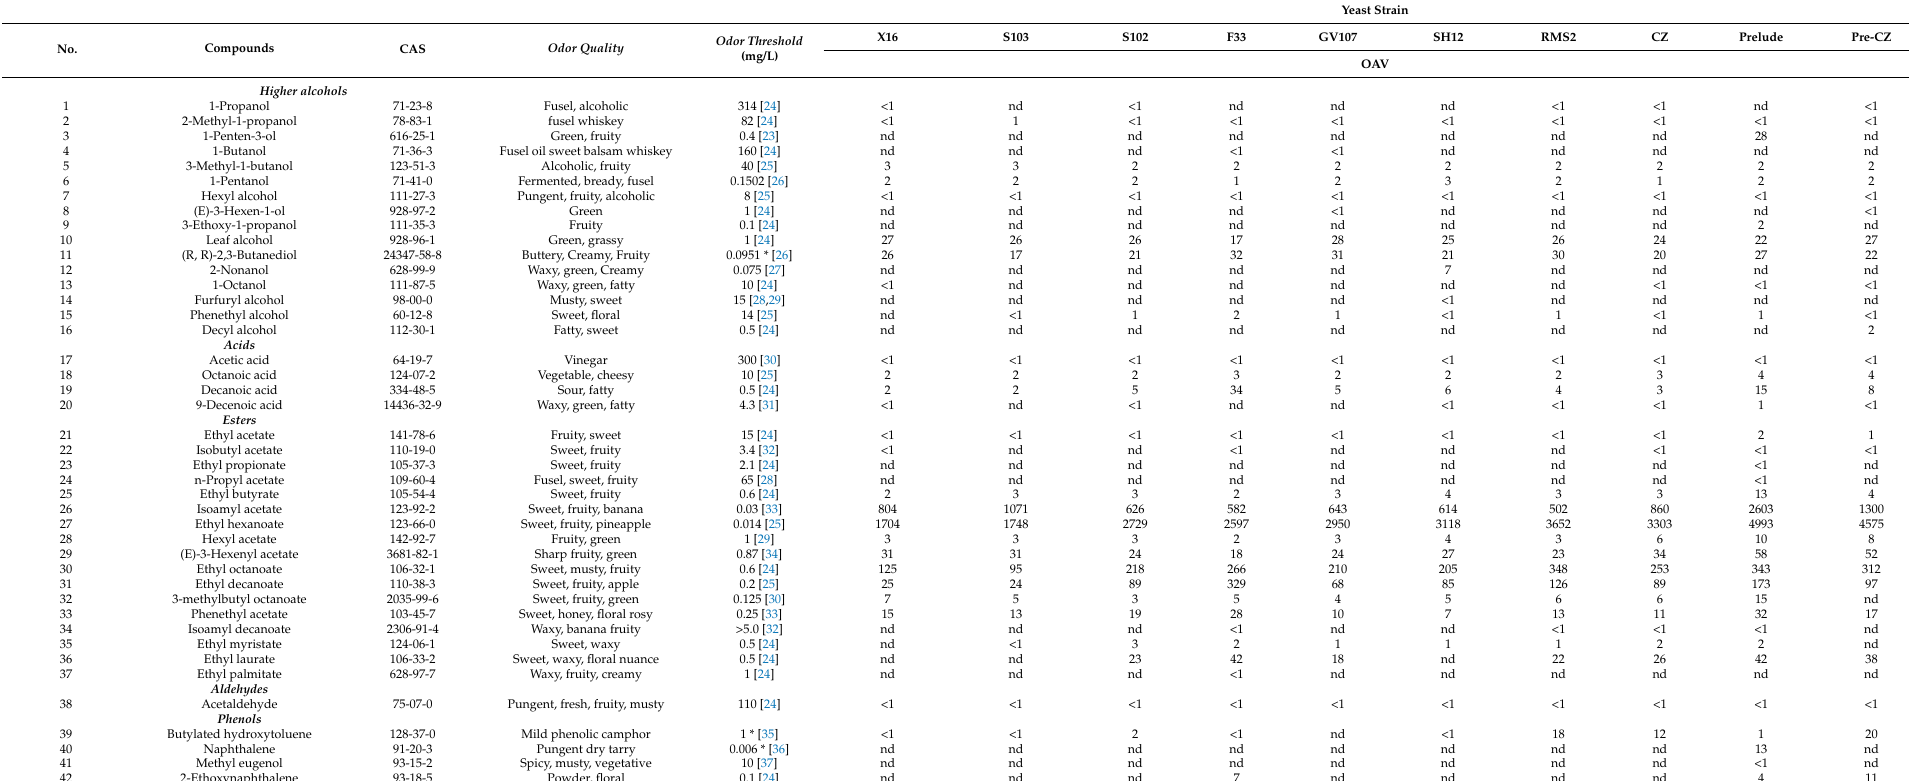
Table 6. Odor activity values of headspace volatile compounds of cili wines fermented by different